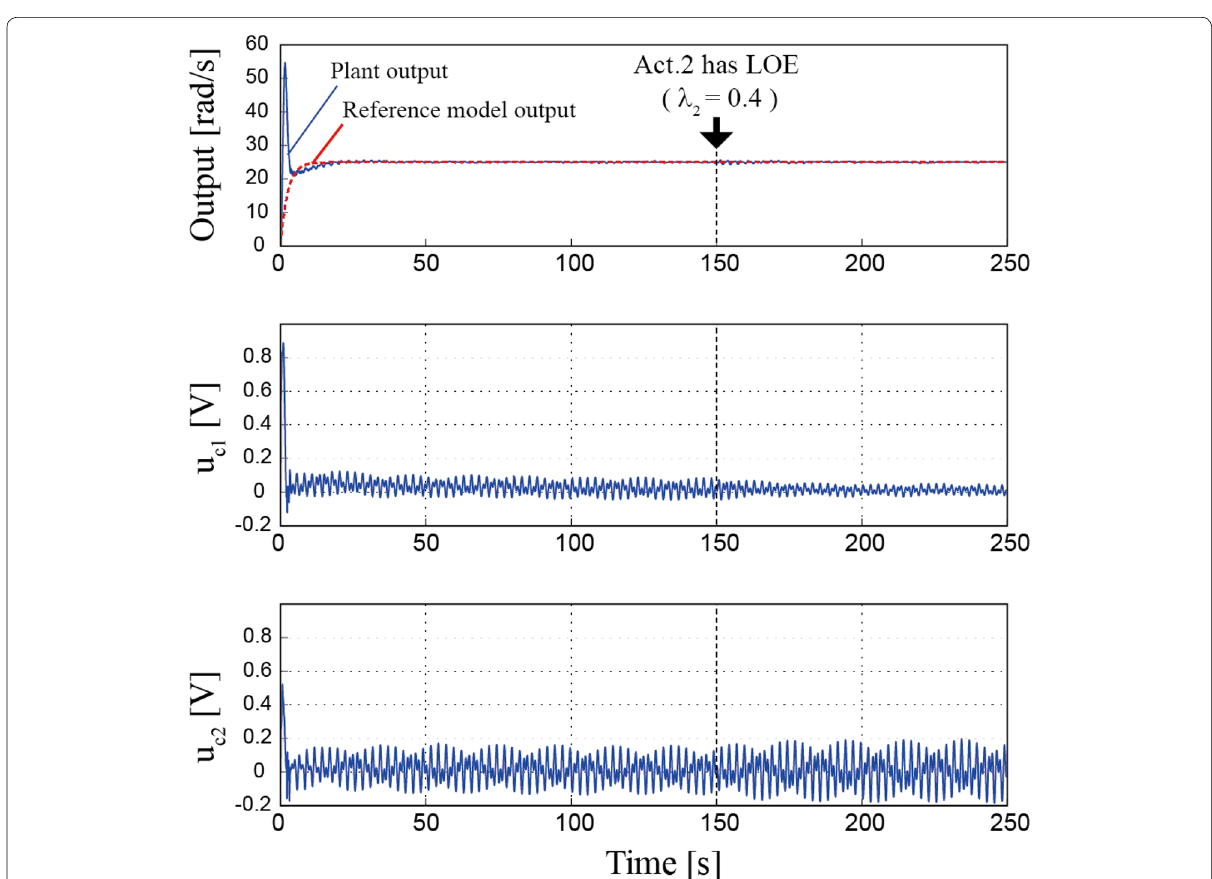
Fig. 14 Experimental result in the case where the second actuator has a partial LOE ( (cid:31) 2 = 0.4 ) after 150